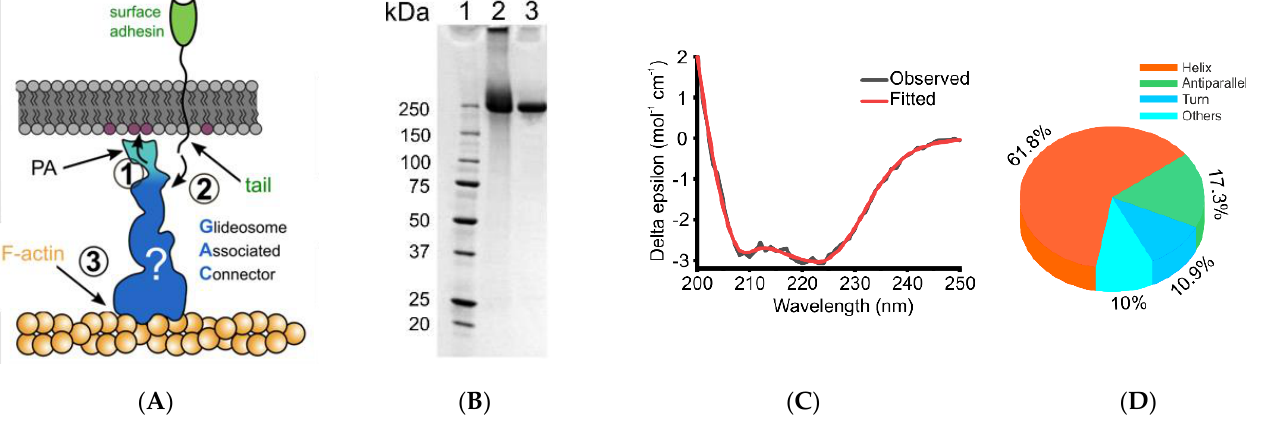
Figure 1. TgGAC interactions, purification and characterisation. ( A ) Schematic representation of GAC interactions with (1) the plasma membrane, (2) surface adhesins and (3) F-actin ( B ) SDS–PAGE of purified full-length TgGAC used for the crystallization trials. Lane 1: molecular-weight markers (kDa), lane 2: Ni-NTA eluted fraction and lane 3: eluted fraction from a Sephecryl S-300 HR SEC column. ( C ) CD spectrum of purified TgGAC measured at 298 K. Black spectrum showed the observed spectrum in 25 mM Tris.HCl, pH 8.0. Red spectrum indicated the fitted line for secondary structure analysis. ( D ) Secondary structure analysis based upon the CD spectrum as indicated in ( C ). Orange indicated the percentage helical content, green is beta-sheet, turn as blue and cyan as other contents in the GAC.